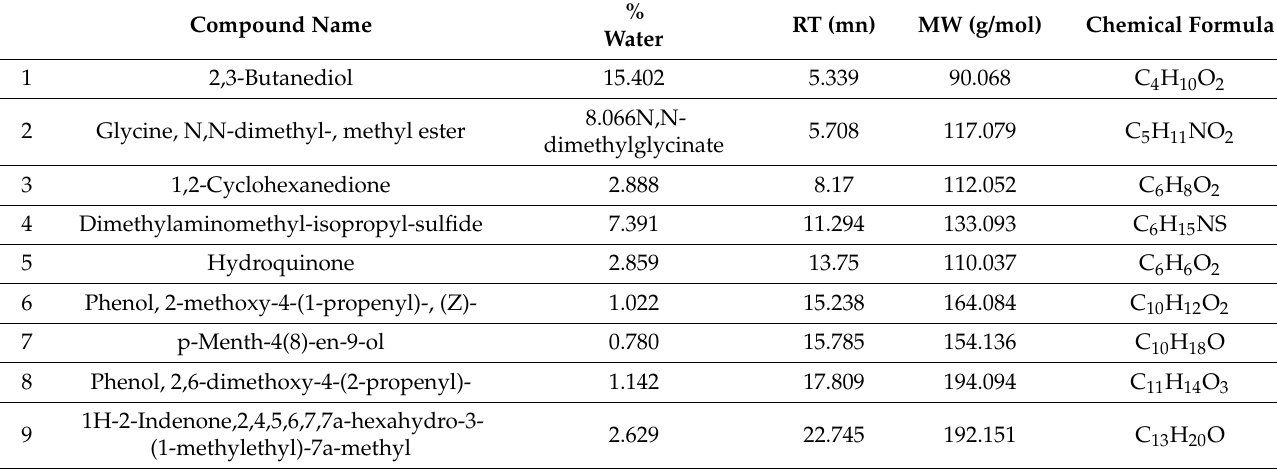
Table 3. Chemical composition of the compounds that are present only in the water R. epapposum